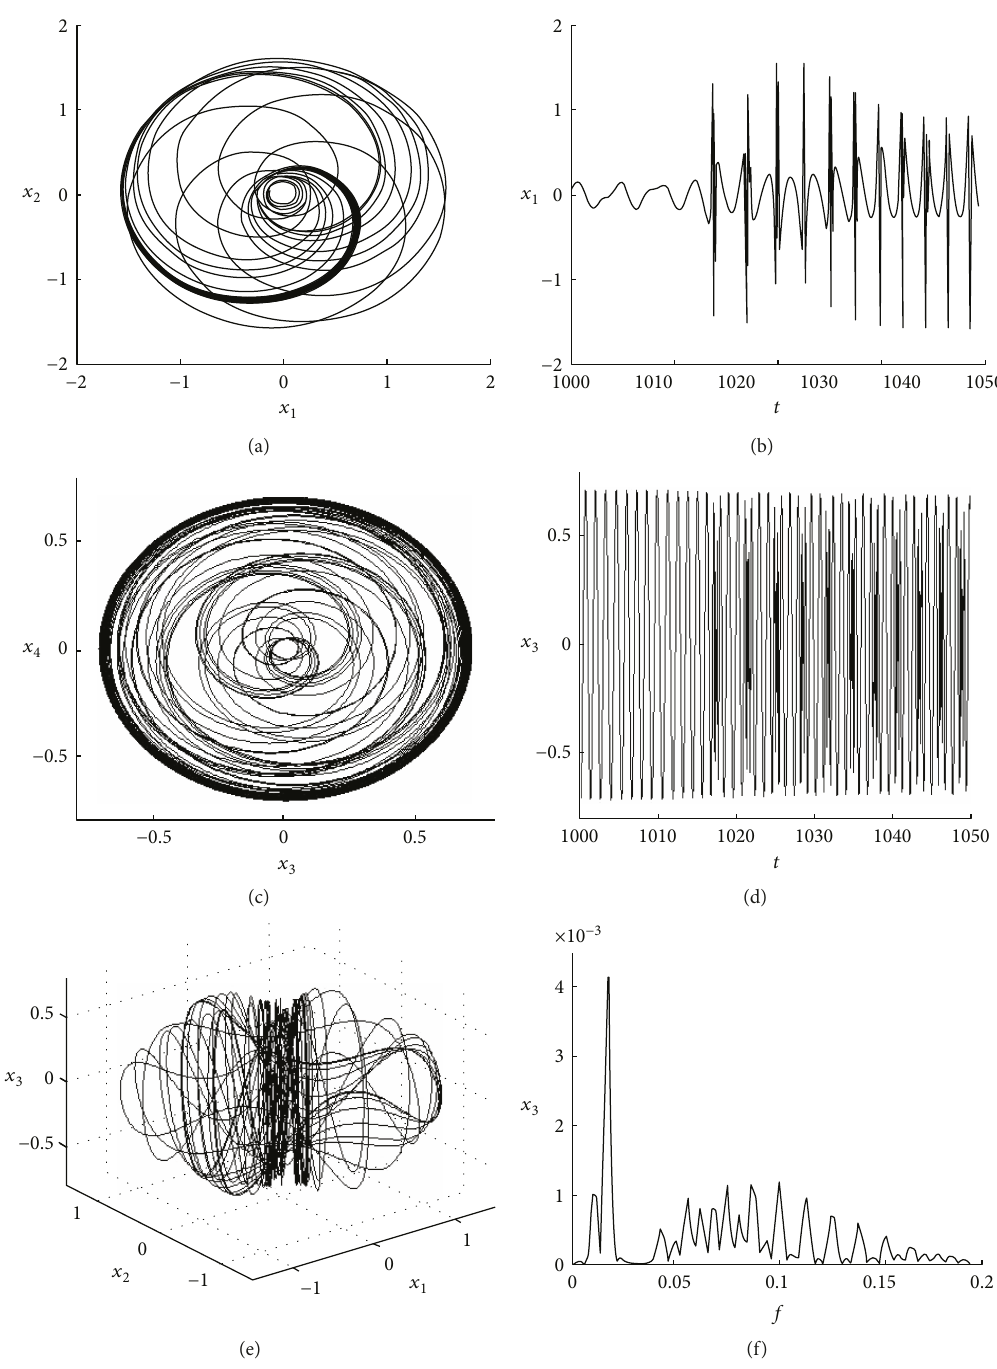
Figure 6: The chaotic motion of the blade with varying rotating speeds when Ω waveform on the plane t , x three-dimensional space x